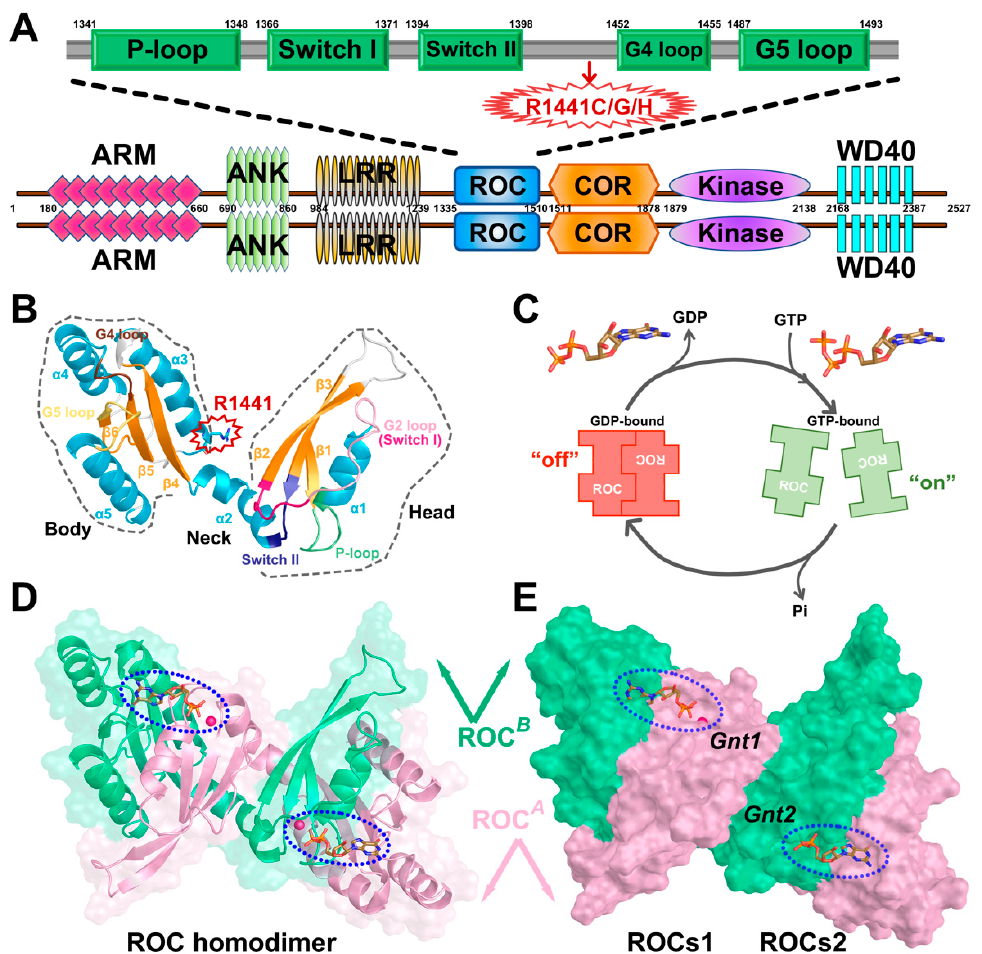
Figure 1. ( A ) Domain architecture of human LRRK2 with its respective amino acid positions. ARM: Armadillo repeats region; ANK: Ankyrin repeat region; LRR: leucine-rich repeats; ROC: Ras-of-complex GTPase domain; COR: C-terminal-of-ROC domain; Kinase: protein tyrosine kinase-like domain; WD40: WD40 repeat. The detailed functional partition of ROC is depicted above with the guanine nucleotide phosphate-binding loop (P-loop), Switch I and Switch II, and G4 and G5 loop highlighted in green rectangles. The residue position R1441 is highlighted with a red arrow. ( B ) Cartoon model of ROC monomer roughly divided into head (including β 1, α 1, β 2, and β 3), neck (including α 2) and body (including β 4, α 3, β 5, α 4, β 6, and α 5) subdomains. The monomer is colored based on a secondary structure, and the P-loop, Switch I, Switch II, G4 loop, and G5 loop are high- lighted in light green, hot pink, purple, brown, and gold, respectively. Residue R1441 is highlighted. ( C ) Schematic model of ROC dimer–monomer dynamic transition during nucleotide turnover based on GAD theory. ( D ) Cartoon model of ROCs-GDP, the two monomers are shown in pink (ROC A ) and green (ROC B ), respectively. ( E ) Molecular surface representation of ROC dimer highlighting the nucleotide-binding pockets (blue-dashed oval). Gnt1 is accommodated by ROC A head and ROC B body, while Gnt2 interacts with ROC A body and ROC B head. Unless otherwise specified, the graphs showing ROCs overview in our work will all be presented from this perspective with Gnt1 residing on the top-left. The presumed compact functional units are denoted as ROCs1 and ROCs2. Nonetheless, with the existing experimental methodologies, it remains challenging to describe the dynamic conformational transition process, especially in the case of bind- ing ligand turnover, which usually results in distinctive structures with different bioac- tivity [19,34–37]. To obtain a comprehensive insight into the dynamics of ROC homodimer during nucleotide shift, we employed large-scale all-atom molecular dynamics (MD) sim- ulation to observe in silico at the atomistic level the intrinsic regulation of GTPase activa- tion cycle of the ROC domain of LRRK2. Furthermore, by integrating our extensive MD